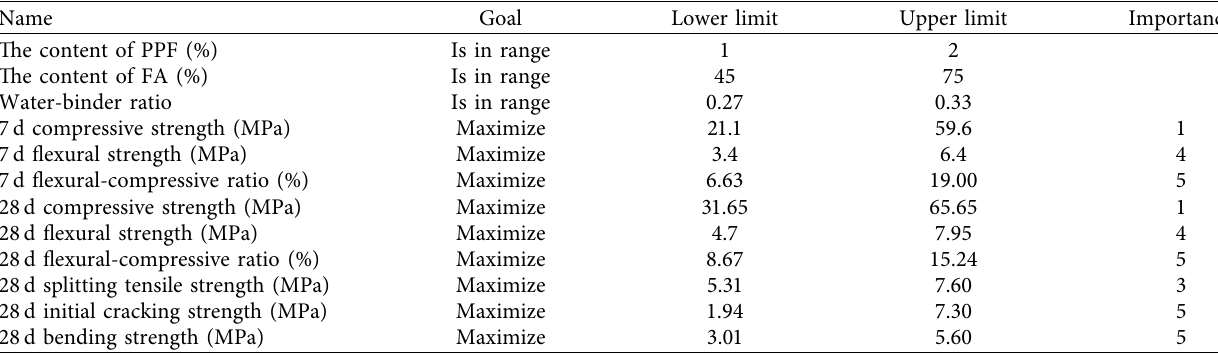
Figure 16: Contour plots. (a, b) 28d initial crack strength (R8). (c, d) 28d bending strength (R9). Table 8: Definition of factors and responses in multiobjective